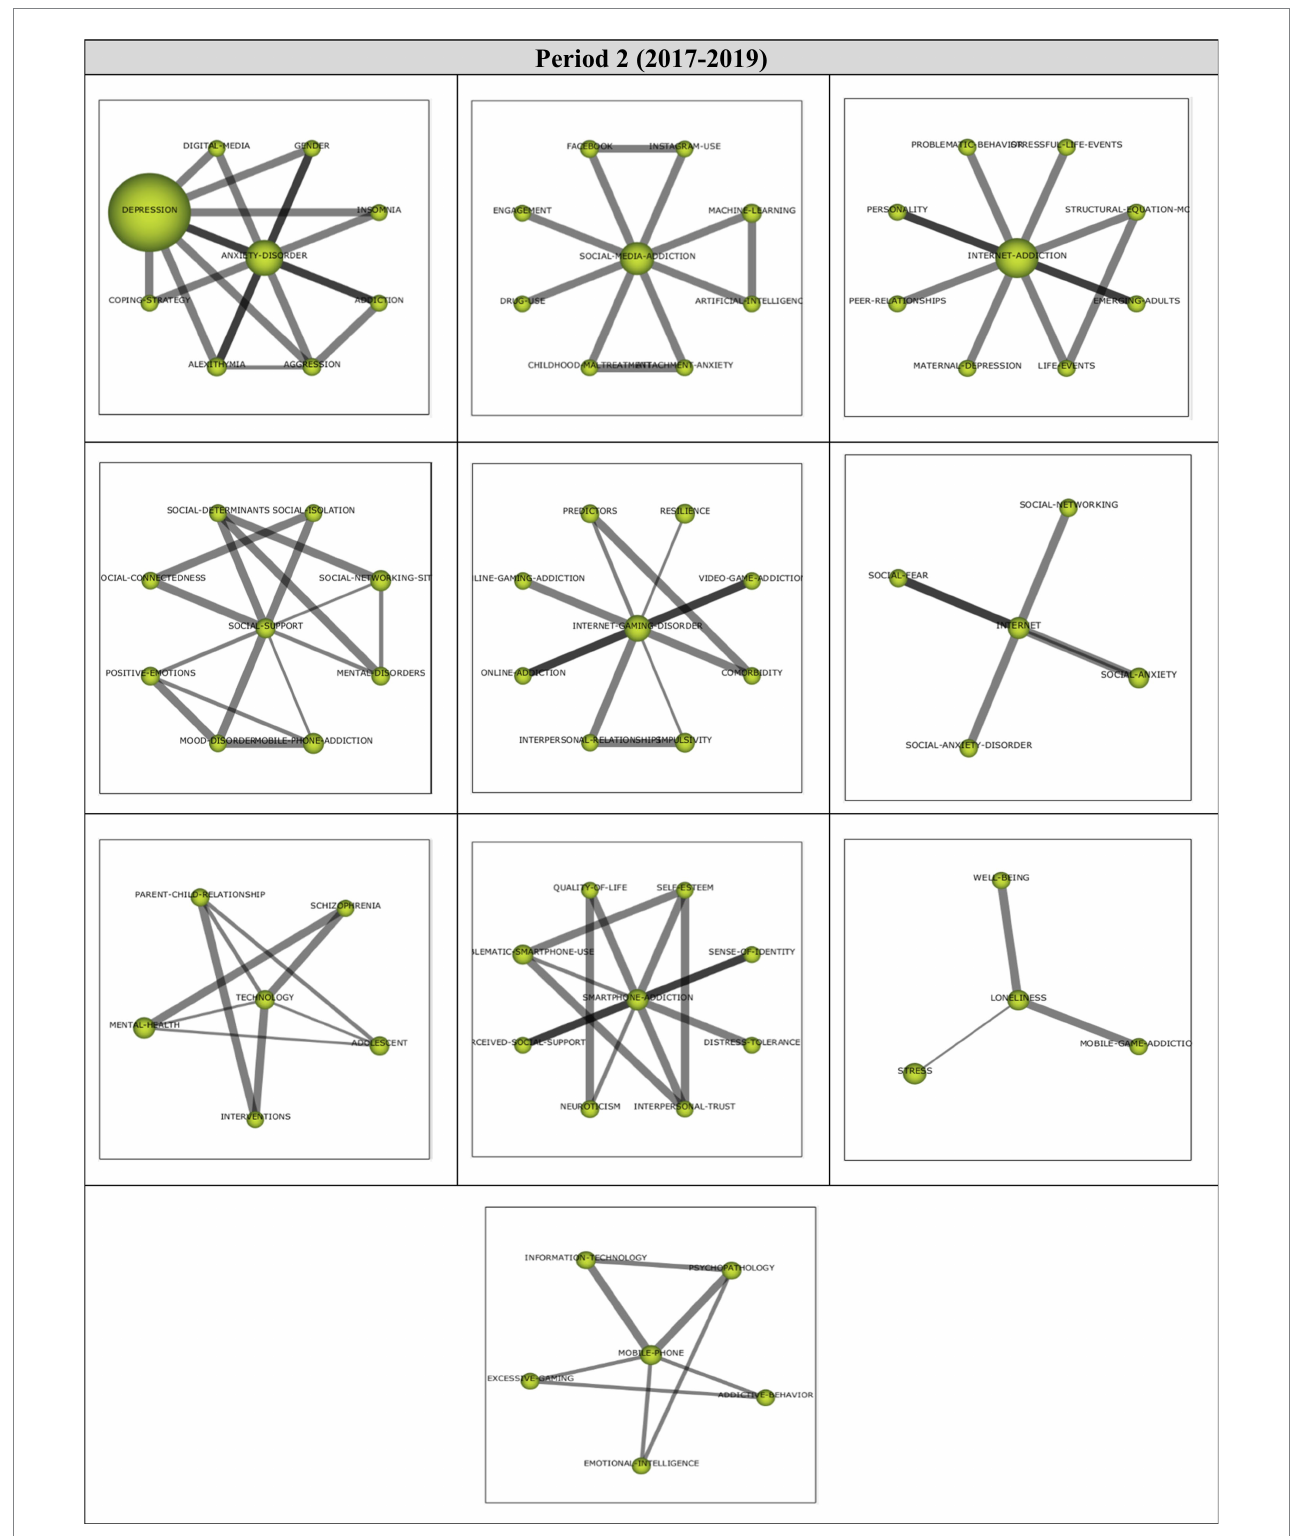
FIGURE 7 Thematic network